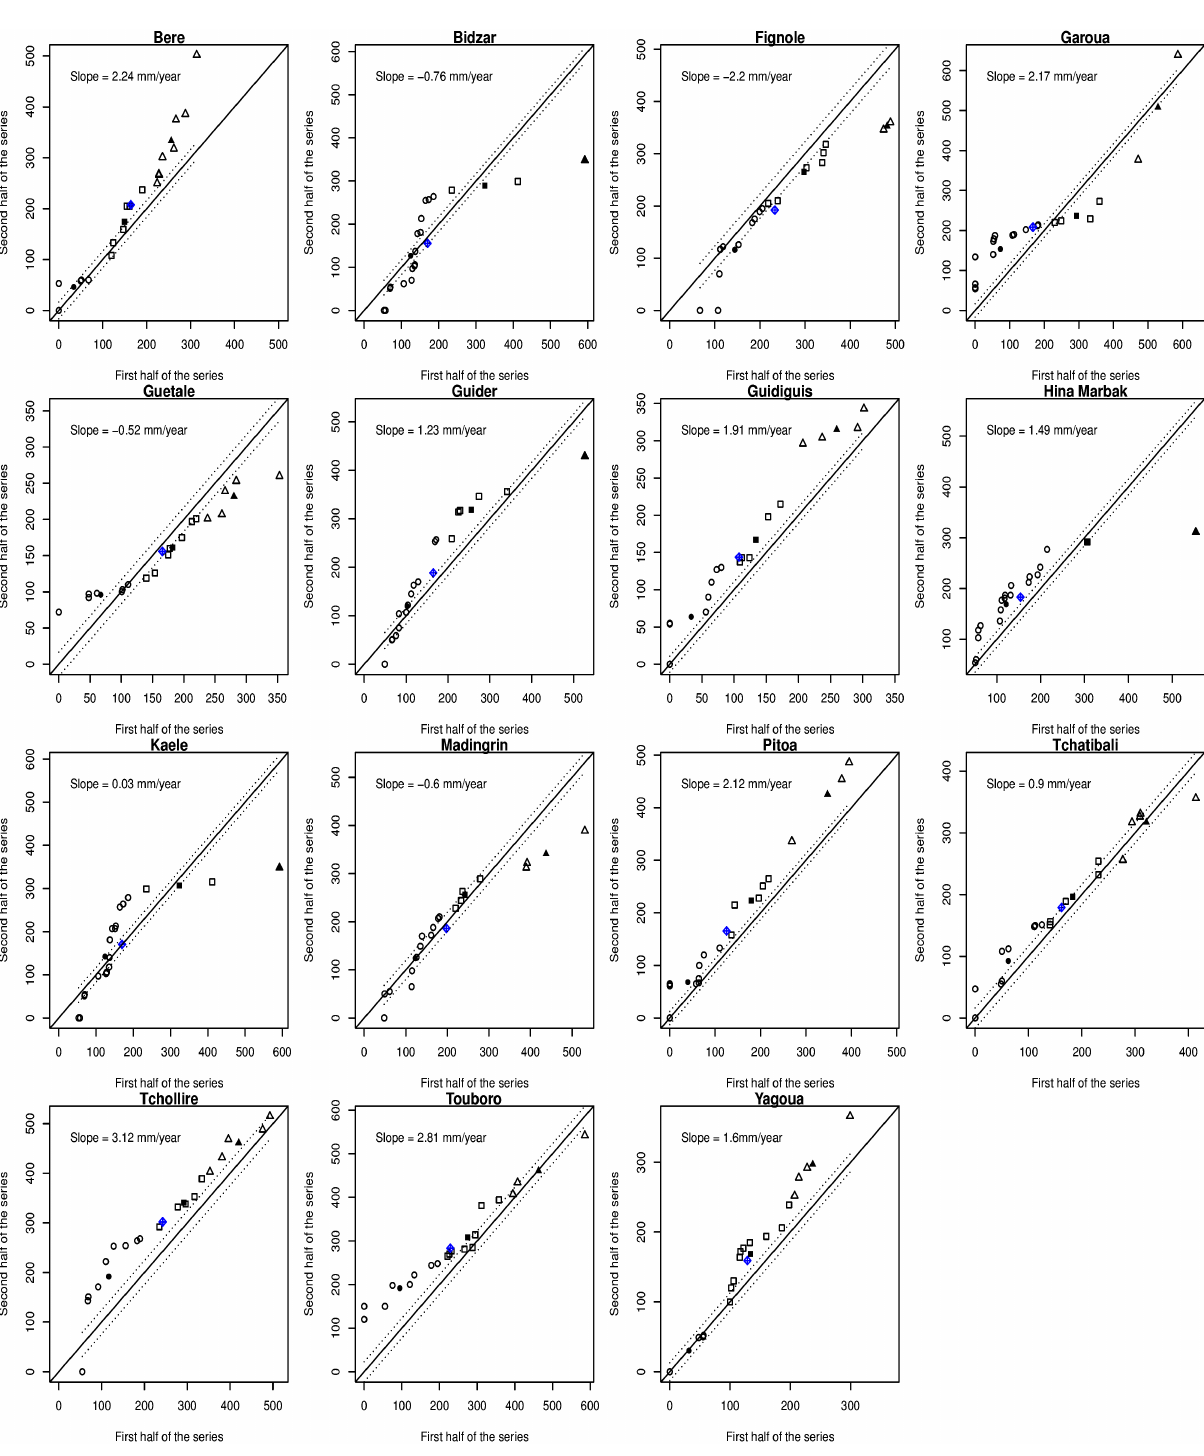
Figure 8. As in Figure 7, but for R95P.